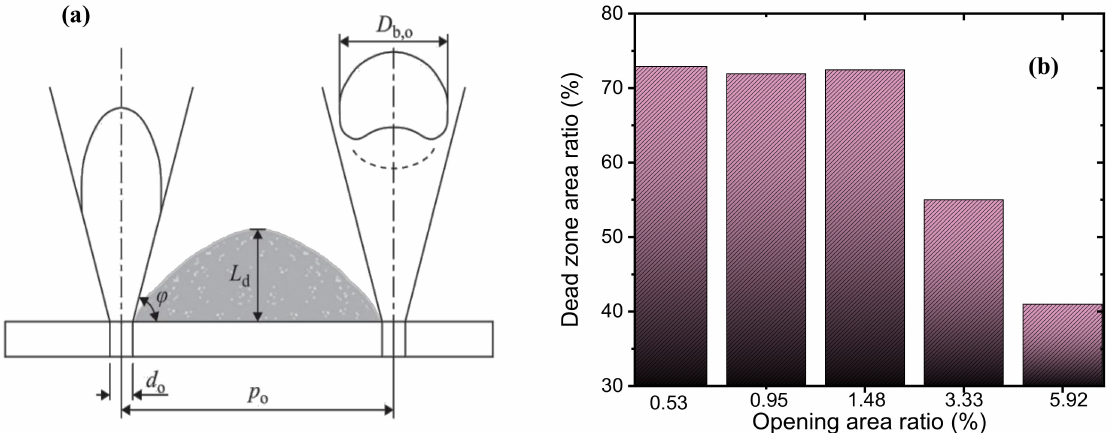
Figure 11. ( a ) Solids dead zone and initial bubble generation immediately above gas distributor; ( b ) effect of open area of distributor on dead zone formation. Adapted from Zhang et al. [70] and Kwangbyol et al.